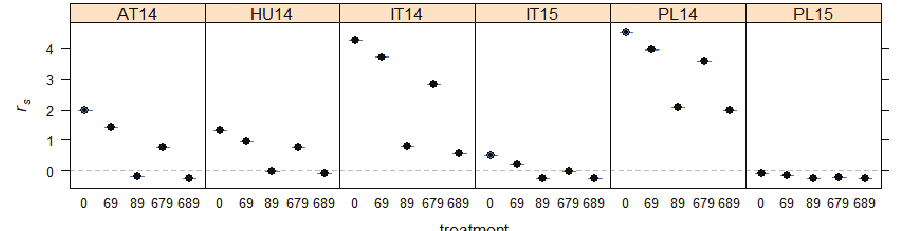
Figure 3. Effect of experimental mowing treatments on stochastic population growth rates r nario H. Panels represent different populations (AT, HU, IT, PL) in year 2014 or 2015 (14 and 15, respec- tively) as detailed in Suppl. material 2, Table S2. The dashed line indicates the population replacement level.